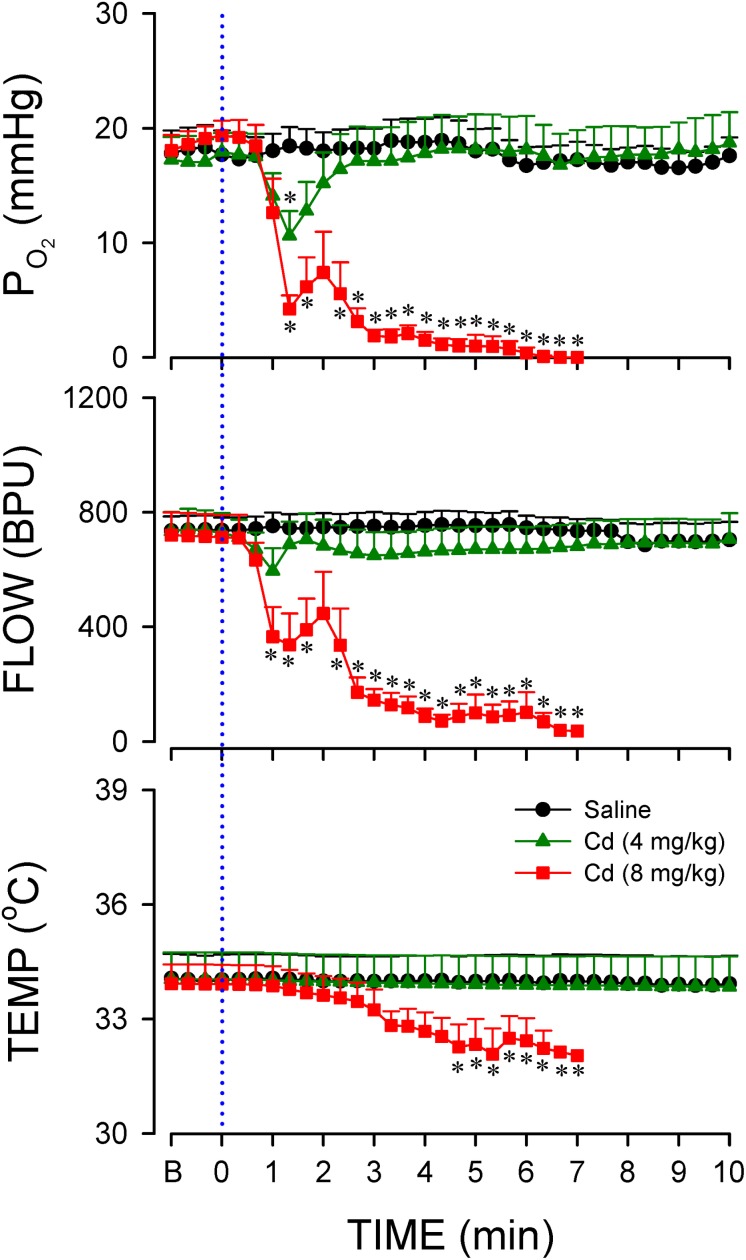
Temporal changes in tissue oxygen tension, microvascular perfusion or temperature in rostral ventrolateral medulla (RVLM) of rats that received intravenous administration of cadmium (Cd; 4 or 8 mg/kg) or saline. Values are mean ± SEM, n = 5–7 animals per experimental group. *P < 0.05 vs. saline group at corresponding time points in the post hoc Scheffé multiple-range test. Blue dotted line denotes time of cadmium injection. B denotes baseline values.